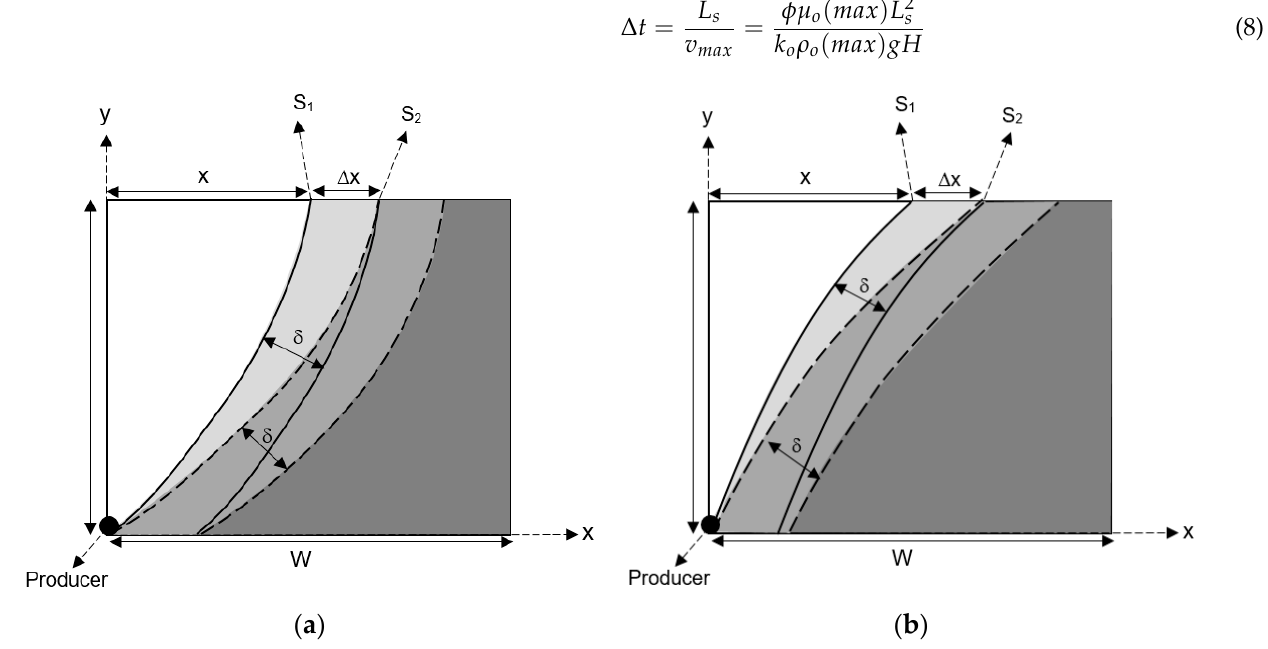
Figure 4. The transition region propagation at the spreading phase having a ( a ) concave shape and ( b ) convex shape.